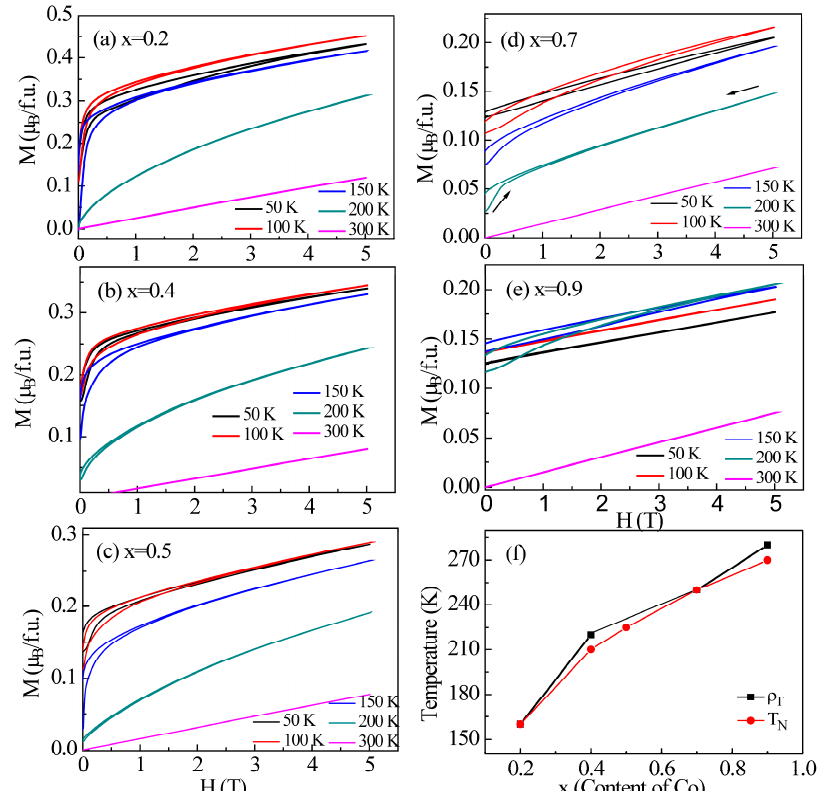
Figure 3. Isothermal magnetization curves M (H) measured from 0 T to 5 T and from 5 T to 0 T at several selected temperatures from 50 to 300 K for Mn 3 Zn 1 − x Co x N ( a ) x = 0.2; ( b ) x = 0.4; ( c ) x = 0.5; ( d ) x = 0.7; ( e ) x = 0.9. The measurement process of the M (H) curves are shown in ( d ) by